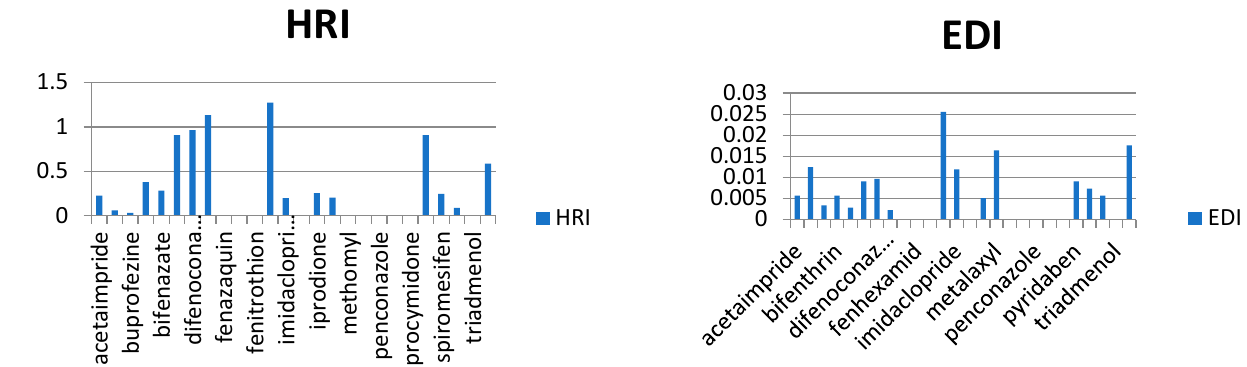
Figure 4. Estimation of EDI and HRI for pesticide residues detected in tomatoes.